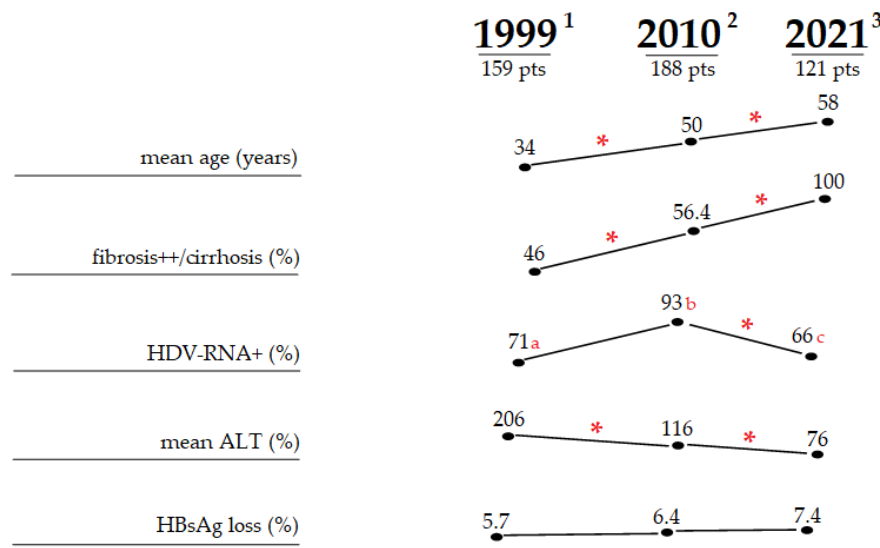
Figure 6. Features of HDV Italians recruited at different time-points. * p value < 0.001. 1 [48], 2 [49] 3 [45]. HDV-RNA measured by a qualitative methods, b semiquantitative PCR, and c quantitative PCR. Table 3. HBsAg liver transplants from 2010 to 2019 in Torino, Italy. Total HBV HDV HBsAg patients, n (%) 259 129 (50%) 130 (50%) Indication for transplant (%) [18] 25.9%